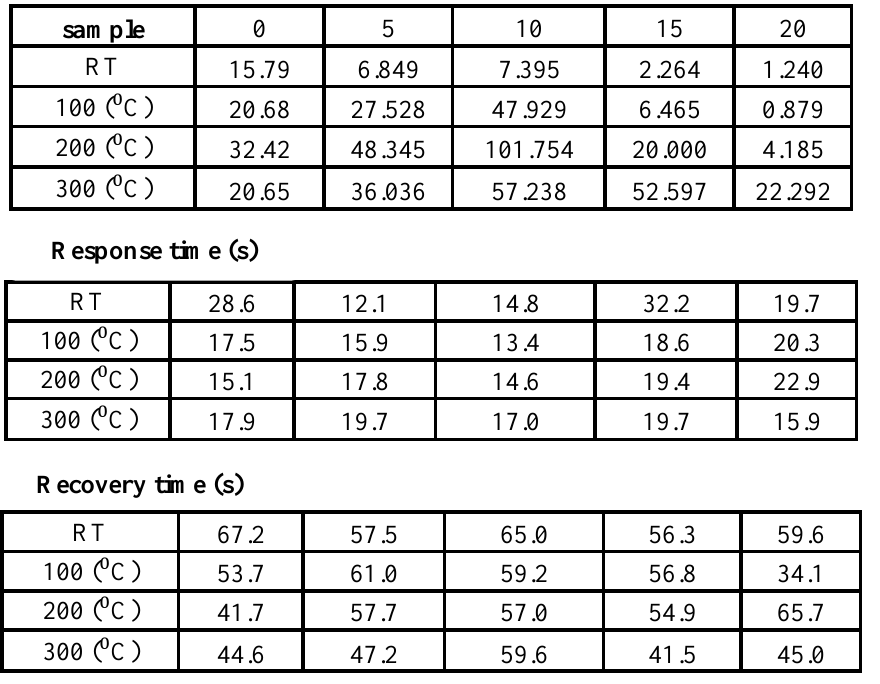
and mixed with 2